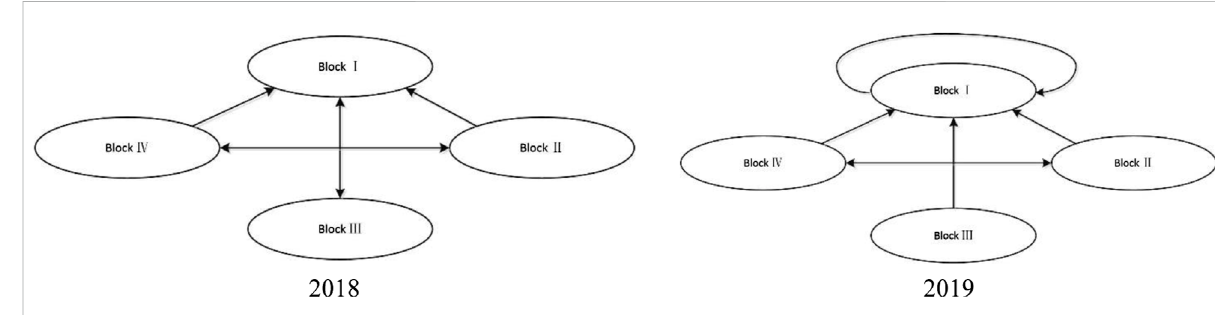
FIGURE 6 Simpli fi ed spillover effect fl ow diagram of four blocks.